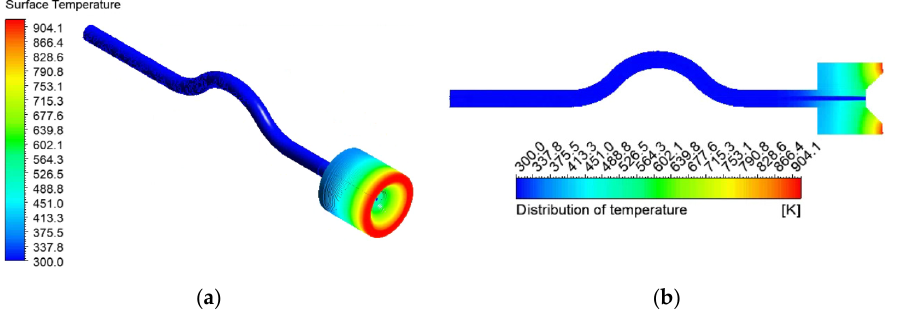
Figure 10. ( a ) Capillary temperature distributions on the outer wall surface at 0.01 s; ( b )